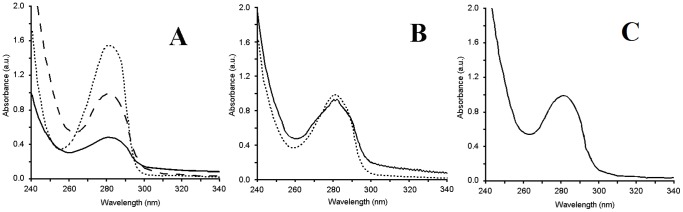
Methylation in vitro using commercially available COMT presented by the spectra of organic phases.(A) OLDA with COMT (continuous line); OLDA without COMT (dashed line); and O-Me-OLDA alone, a presumed reaction product, (dotted line). (B) OLDA with COMT (continuous line) and 1∶1 artificial mixture of OLDA and O-Me-OLDA (dotted line). The identity of the two spectra in Panel B points to the presence of OLDA and O-Me-OLDA in the reaction mixture. (C) Spectrum of the organic phase of the control mixture with no COMT added, incubated for the same length of time as was the full reaction with COMT.